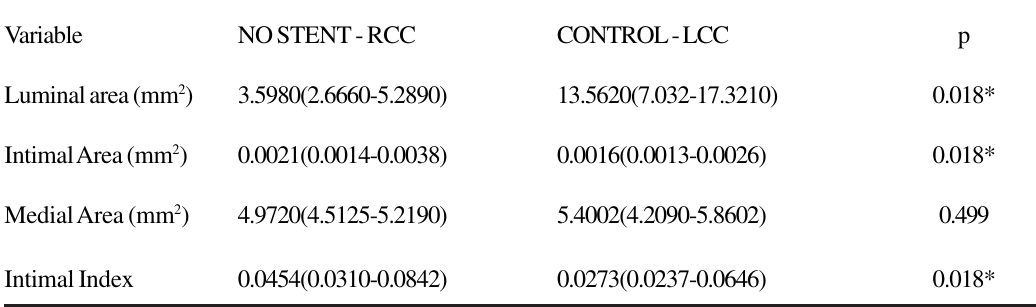
TABLE 3 - Morphometric analysis of areas in the NO STENT group